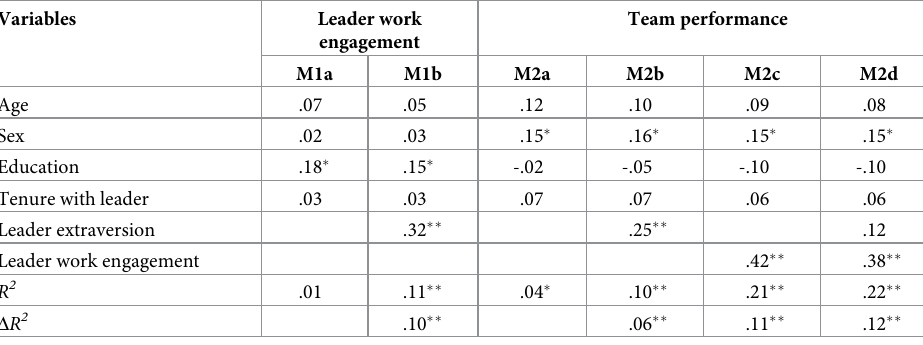
Table 4. Mediating effect of leader work